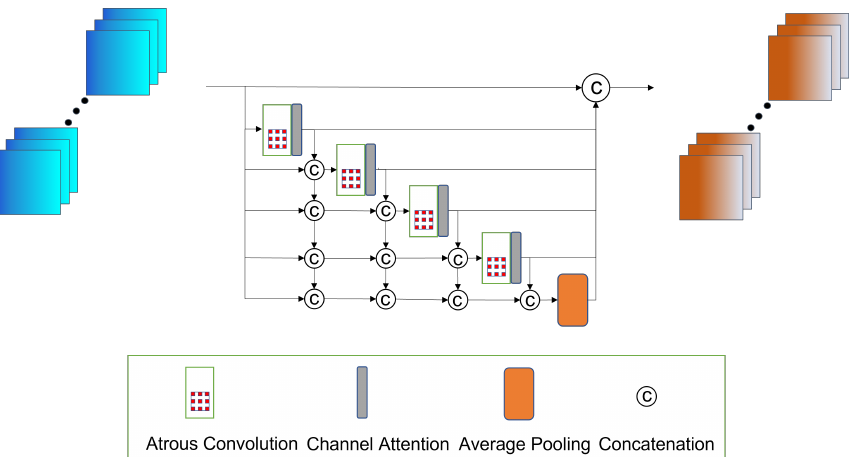
Figure 3. Channel-attention-based densely connected atrous spatial pyramid pooling (CADenseA- SPP). The atrous convolution layers and an average pooling layer are densely connected, and a channel attention module is added just after each atrous convolution